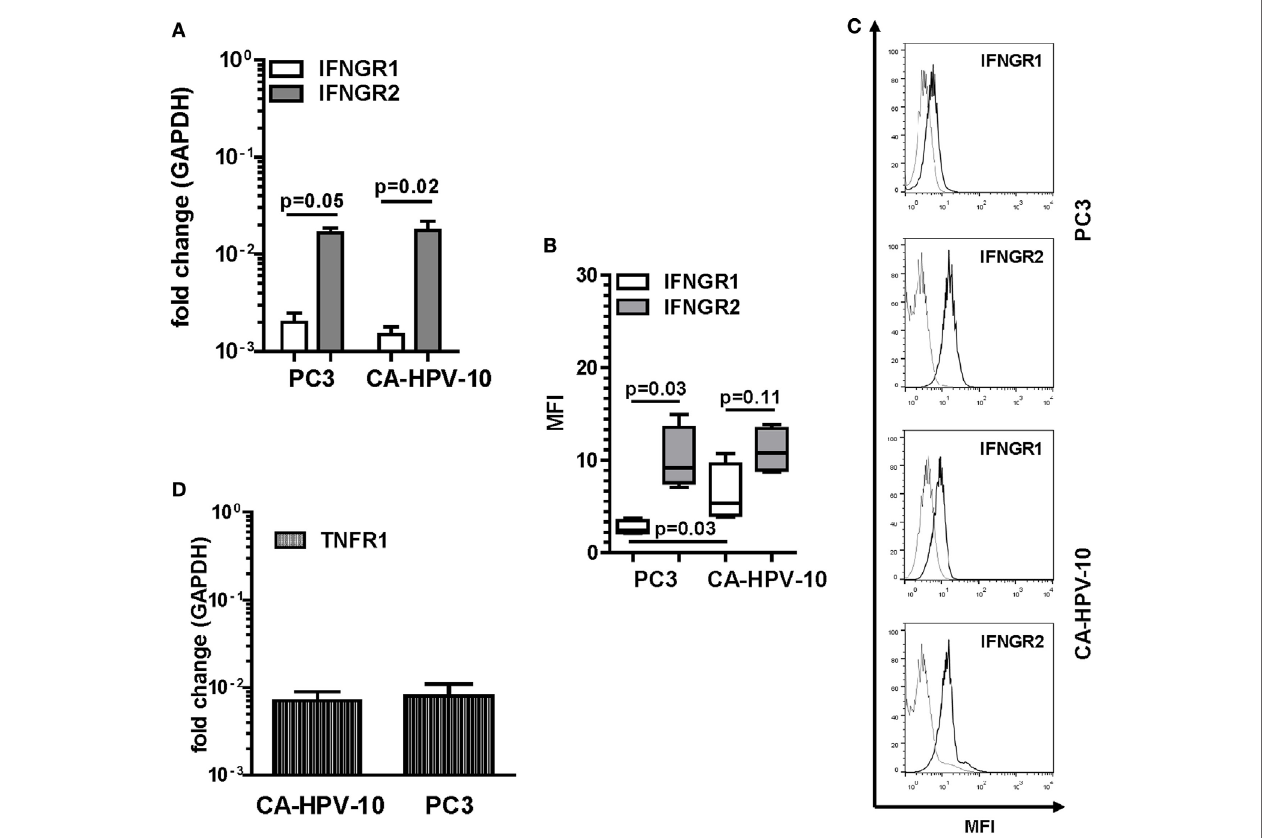
FigUre 2 | Interferon gamma receptors (IFNGRs) and tumor necrosis factor receptor 1 (TNFR1) gene and protein expression in prostate cancer (PCa) cell lines. (a) Gene expression of IFNGR1 (white bars) and IFNGR2 (gray bars) in PC3 and CA-HPV-10 cell lines. A higher expression of IFNGR2 than of IFNGR1 was observed in both cell lines (Mann–Whitney U test, PC3 p = 0.05 and CA-HPV-10 p = 0.02). (B) Mean fluorescence intensity (MFI) by fluorescent-activated cell sorting of IFNGR1 (white boxes) and IFNGR2 (gray boxes) specific staining in PC3 and CA-HPV-10 cell lines. (c) Representative overlaid histograms refer to MFI of IFNGR1 and IFNGR2, when compared with isotype staining. IFNGR2 was expressed to higher extents than IFNGR1 only in PC3 (Mann–Whitney U test, p = 0.03). IFNGR1 was expressed to a higher level in CA-HPV-10 than in PC3 cells (Mann–Whitney U test, p = 0.03). (D) TNFR1 gene expression in PC3 and CA-HPV-10 cell lines. No significant differences were observed between cell lines (Mann–Whitney U